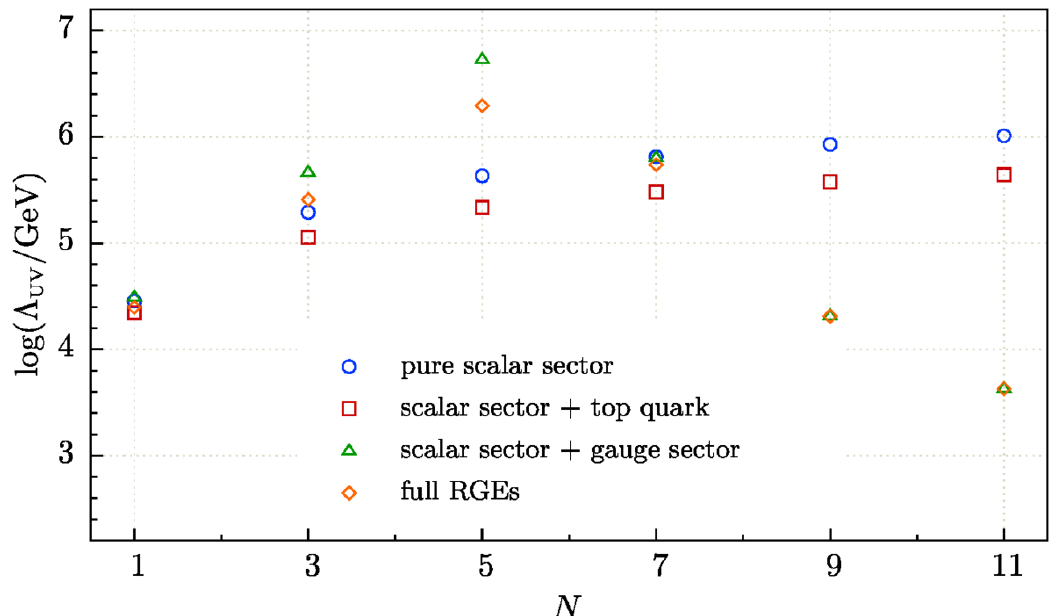
Figure 1 . Largest possible UV scale in extensions of the conformal SM by one real SU(2) L N -plet with vanishing vev. The color code indicates which set of beta functions and couplings are taken into